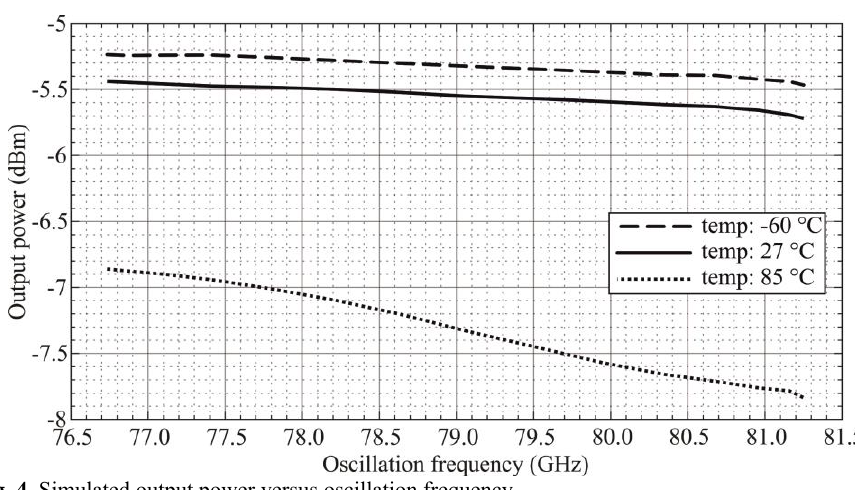
Fig. 4. Simulated output power versus oscillation frequency.